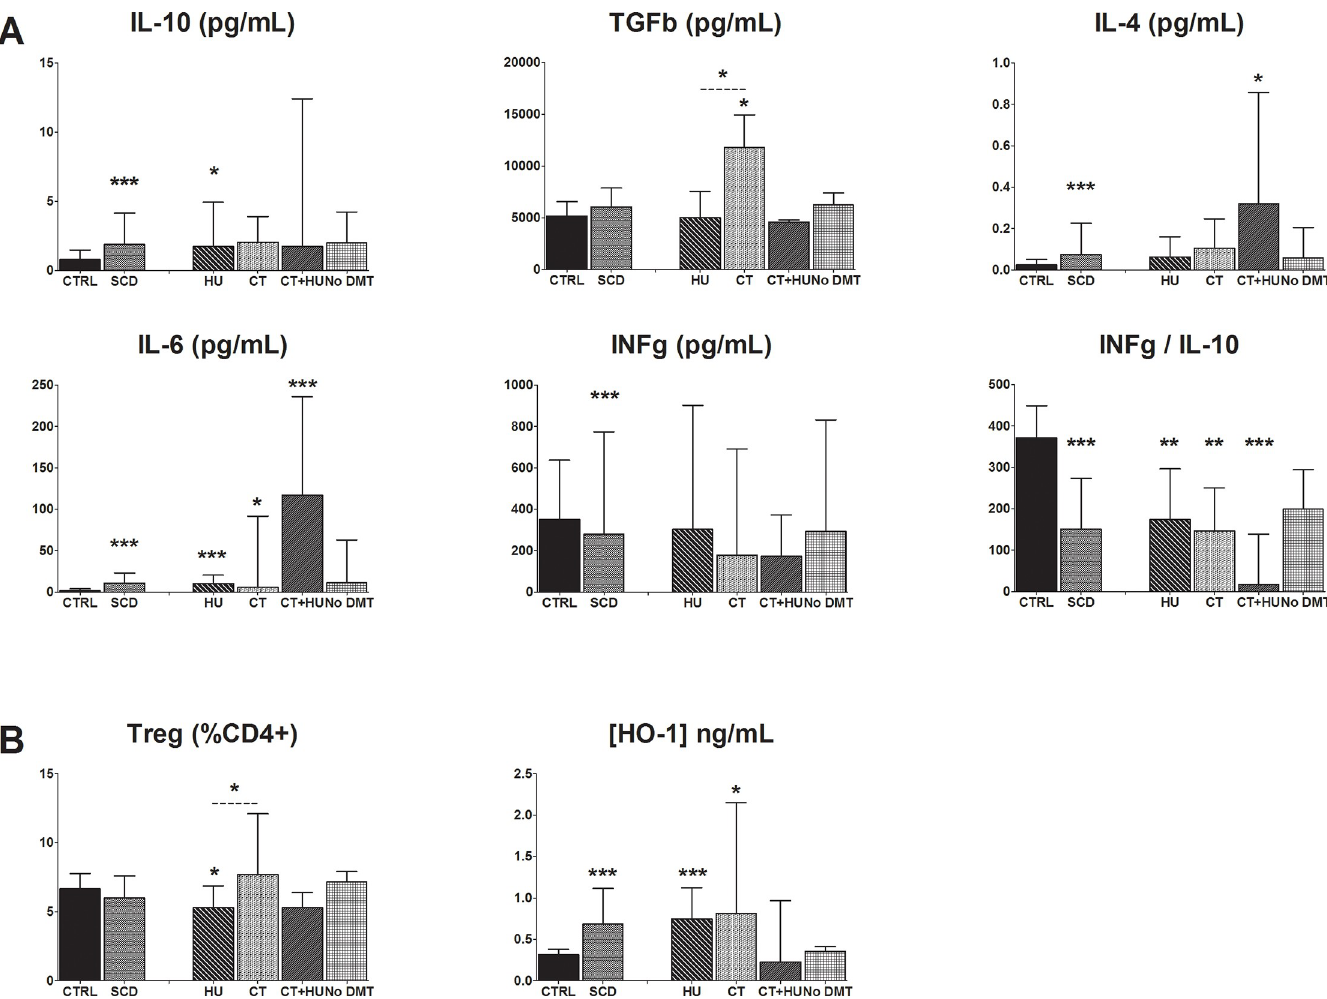
Fig 4. Distribution of cytokine levels, regulatory T cells and HO-1 concentration in SCD patient treatment groups versus healthy controls. (A) Levels of IL-10, TGF β , IL-4, IL-6, INF γ and INF γ /IL-10 were assessed by a multiplex assay. (B) Levels of Treg cells were assessed by MFC and HO-1 concentration in cell lysate was evaluated by an ELISA assay. Comparison between SCD combined groups and healthy control groups were assessed by two tailed nonparametric Mann-Whitney test. Comparison between SCD subgroups according to their treatment and the healthy control group were assessed by the nonparametric Kruskal-Wallis analysis of variance, followed by a Dunn’s multiple comparison test. P-value above bar represent comparison to the healthy control group. Other significant associations are shown. HU, Hydroxyurea; CT, Chronic transfusion; No DMT, No Disease modifying therapy. � p < 0.05; �� p < 0.01; ��� p < 0.005.